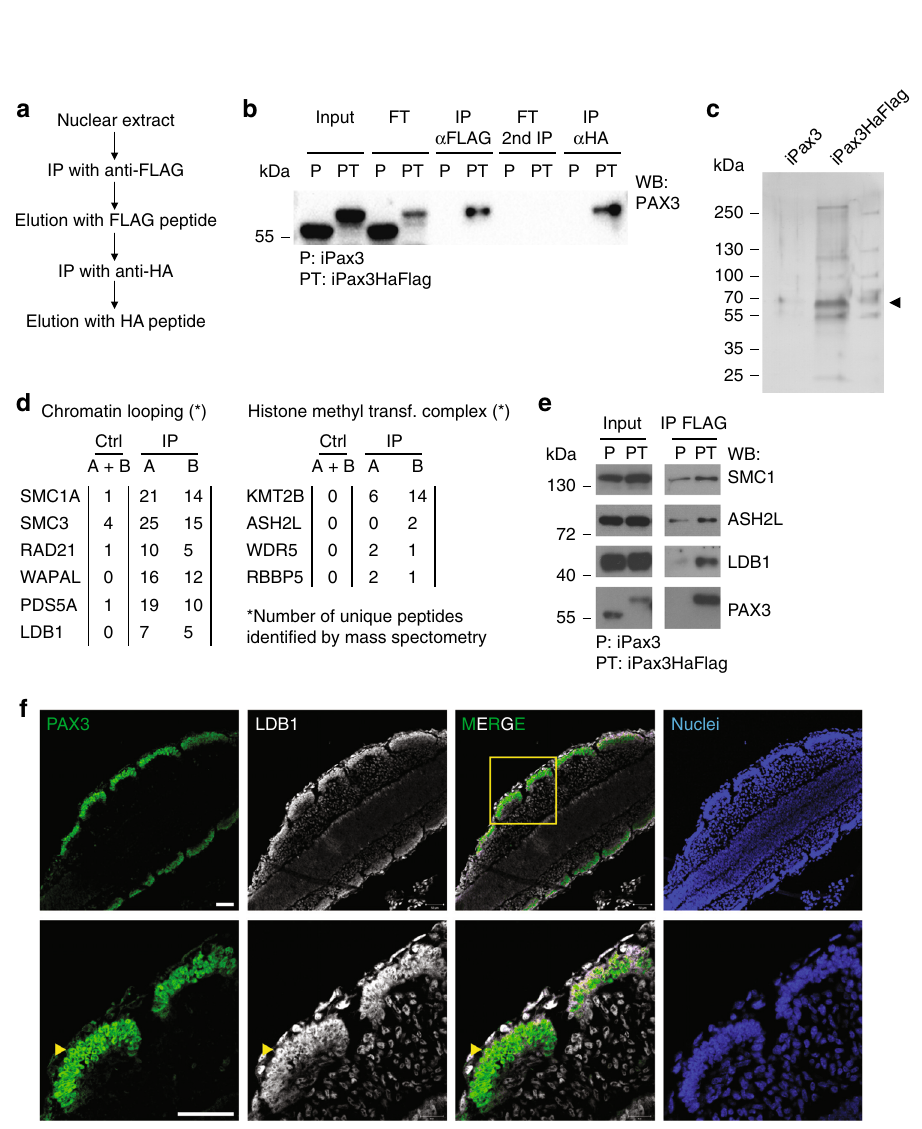
Fig. 3 Identi fi cation of the PAX3 protein complex by mass spectrometry. a Scheme of tandem af fi nity puri fi cation of PAX3. b Western blot using anti-PAX3 antibody. c Silver staining of TAP samples from iPax3 and iPax3HaFlag 1-day induced EBs. d Unique peptides detected for proteins associated to chromatin looping and histone methylation. e Validation of PAX3 interaction with LDB1, ASH2L, and SMC1 in 1-day induced EBs. Images are representative of independent biological replicates ( n = 3). f Immuno fl uorescence staining shows co-localization of PAX3 and LDB1 in the somites of E9.5 embryos. Upper panel: ×20 magni fi cation. Lower panel ×63 magni fi cation. PAX3 (green); LDB1 (white); Nuclei (blue). Scale bar: 50 µ m. Source data are provided as a Source Data fi